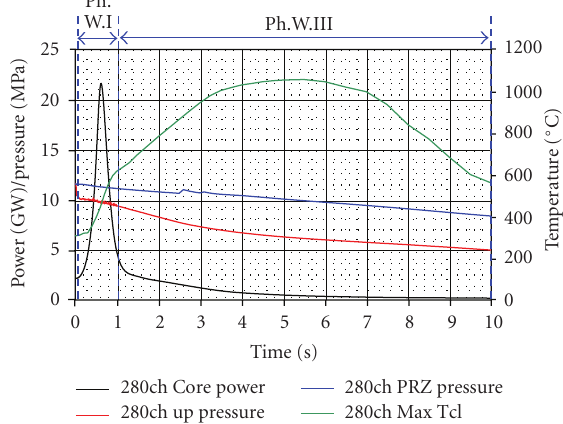
Figure 1: Power, pressure, and maximum cladding temperature, “280ch” 3D-NK.